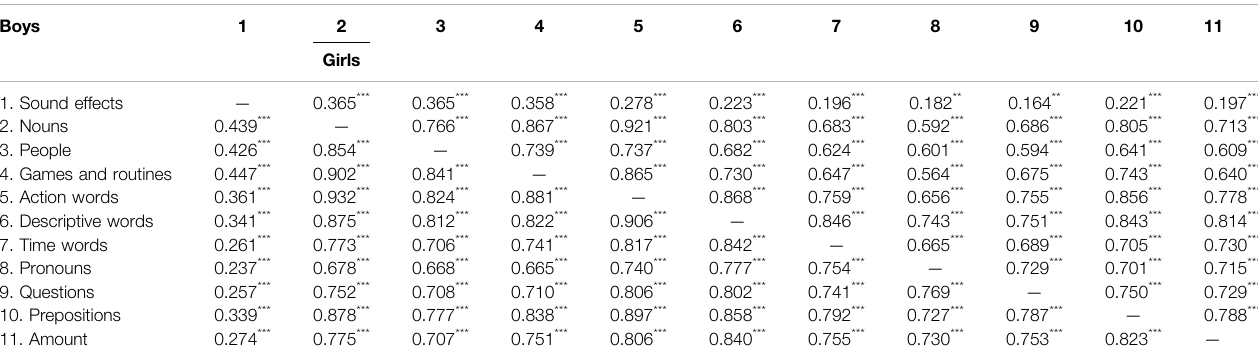
TABLE 3 | Correlations between growth in lexical categories in boys and girls aged 13 – 24 months (Pearson